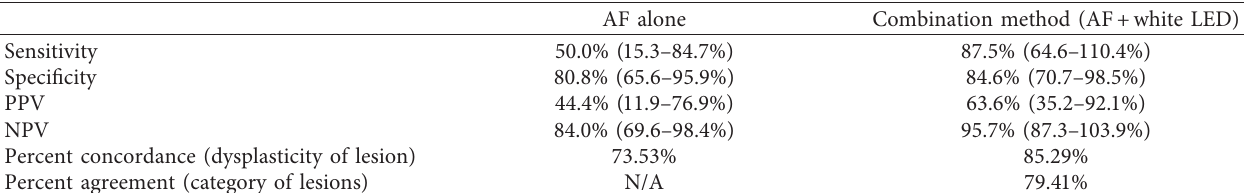
Table 3: Validity and reliability of the devices.